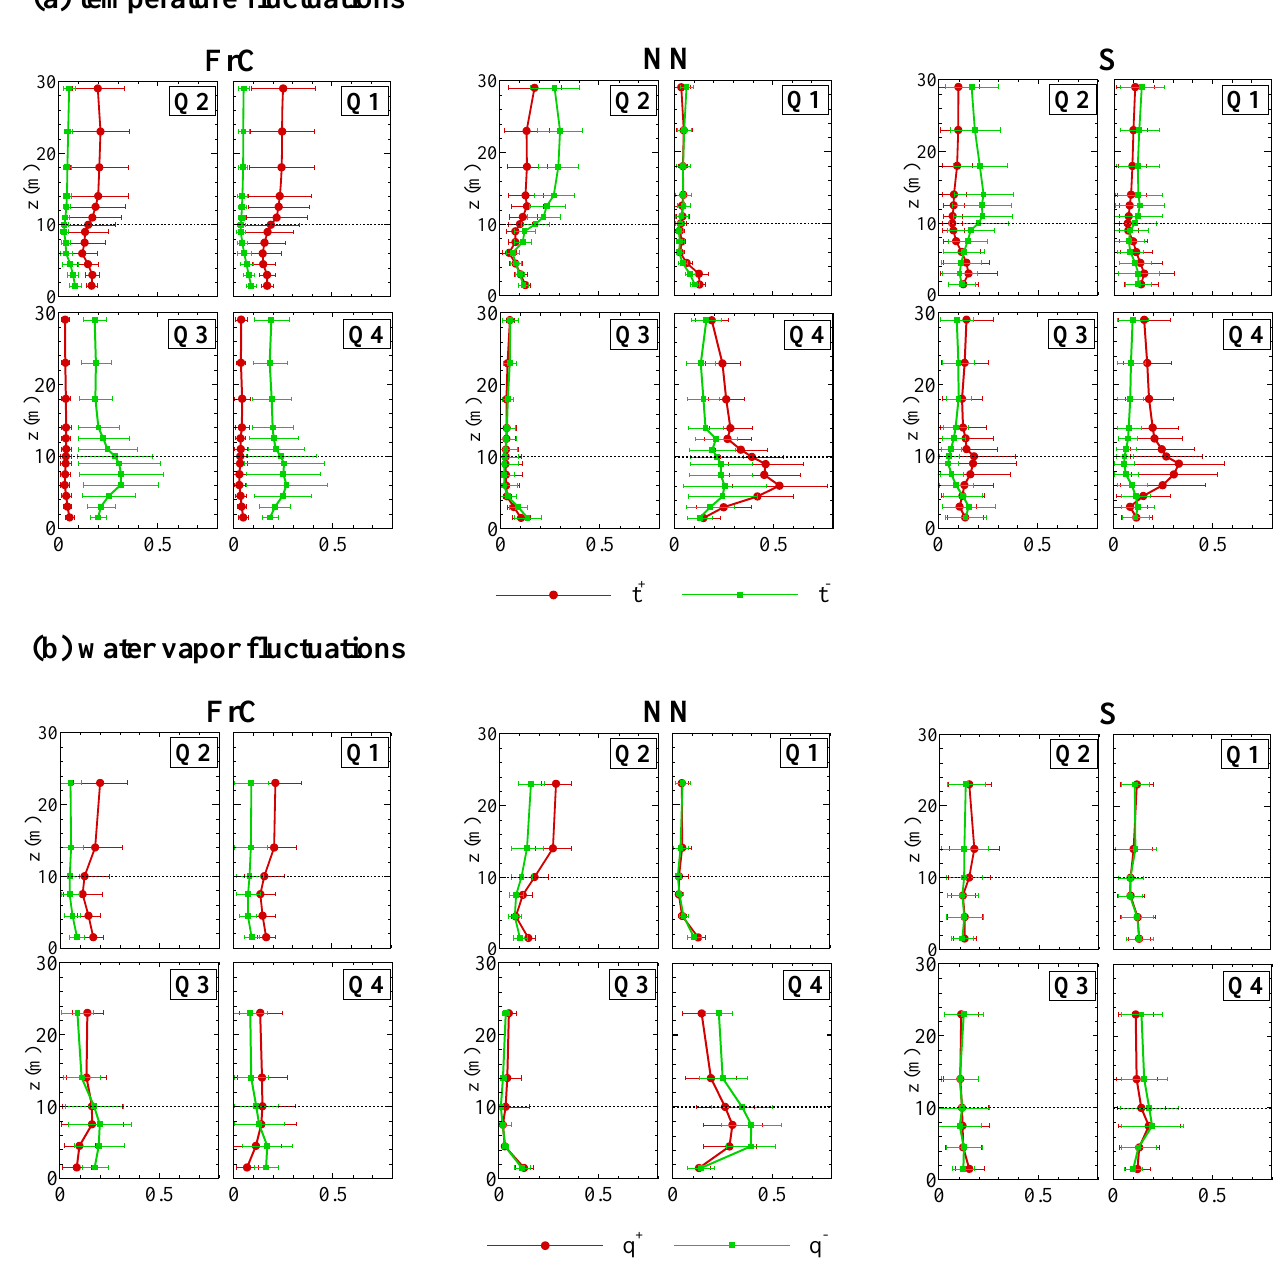
Fig. 2. Fraction of the momentum flux h u 0 w 0 i in each momentum quadrant and associated with positive or negative (a) temperature and (b) water vapor fluctuations, as defined in Eqs. (6) and (7). The three main stability regimes (FrC, NN and S) are presented for the period with no-leaves. The quadrants are defined in Table 2. Error bars indicate the standard deviation of the fractions. The dashed line indicates the canopy